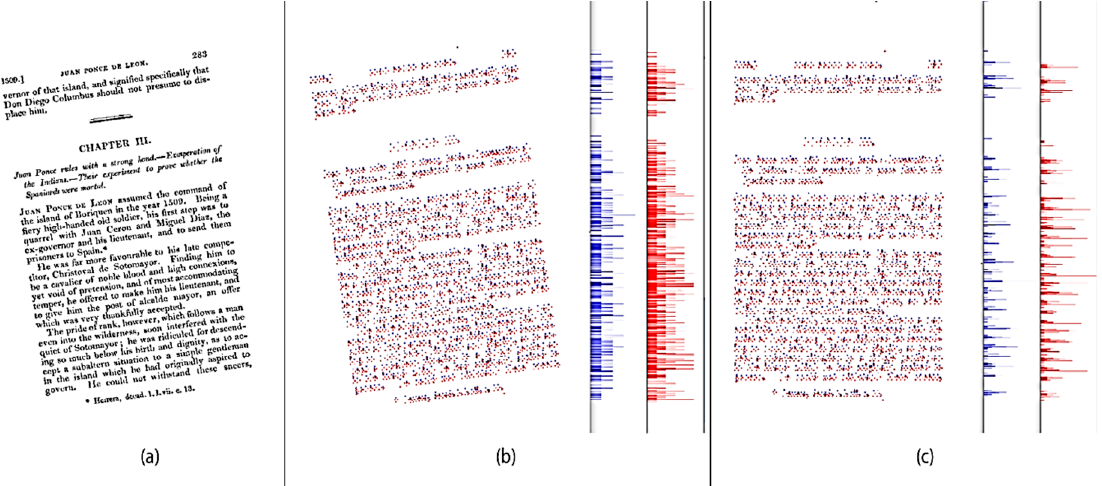
Figure 4. (a) Input: skewed document; (b) points of connected components’ axis-aligned bounding boxes (AABBs): top (blue) and bottom (red) sides and their associated scanline histograms; (c) same as ‘(b)’, but the histograms have maximum variance as the page is correctly oriented.